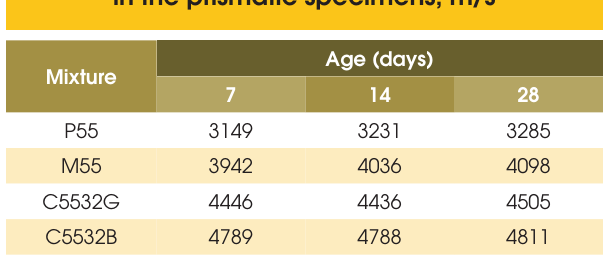
for paste, mortar, and concrete mixtures with the same w/c